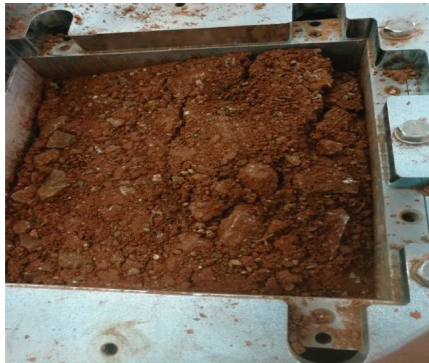
Figure 4: The nonuniform deformation of S-RM after the shear process without shear